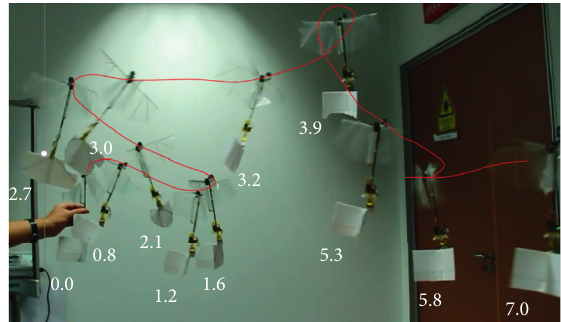
Figure 15: T-shaped tail fin flapping-wing flight without control.